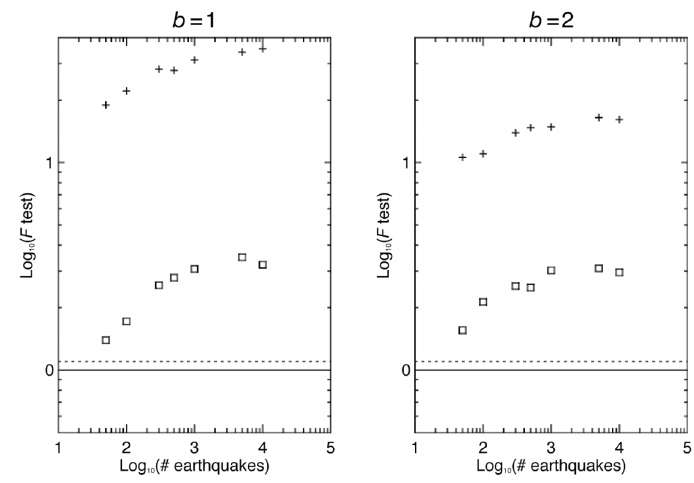
Fig. 2. F test values (see eq. (2.2)) for the case of figs. 1 and 4 (see text). The plus signs represent the cumu- lative regression, and the squares the binned regression. The dotted line represents the critical value to reject the null hypothesis at a significance level of 0.05. Note the logarithmic scale also on the vertical axis.